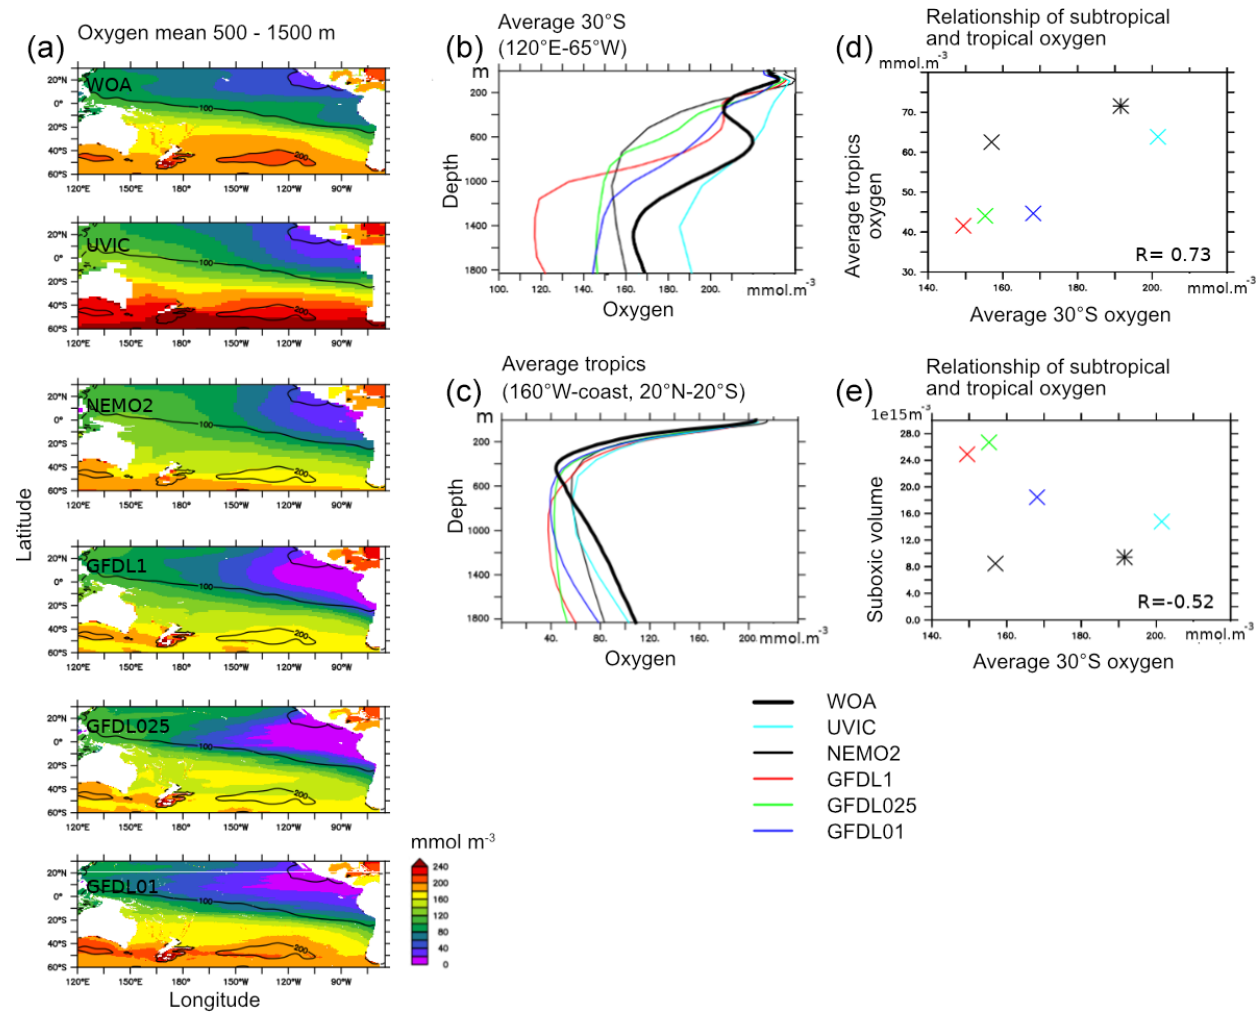
Figure 2. (a) Oxygen levels (mmolm − 3 ) in observations (World Ocean Atlas – WOA) (mean 500–1500m) and models (UVic, NEMO2, GFDL1, GFDL025, GFDL01). Contours correspond to WOA values. (b) Average “30 ◦ S” (120 ◦ E–65 ◦ W, 30 ◦ S). (c) Average “tropics” (160 ◦ W–coast, 20 ◦ N–20 ◦ S). (d) Average “30 ◦ S” vs. “tropics”. (e) Average “30 ◦ S” vs. volume of tropical suboxic ocean (oxygen lower than 20mmolm − 3 ) regions (10 15 m 3 ). (b–e) UVic: black, NEMO2: cyan, GFDL1: red, GFDL025, green; GFDL01: blue, WOA: bold line (b, c) and star (d, e)